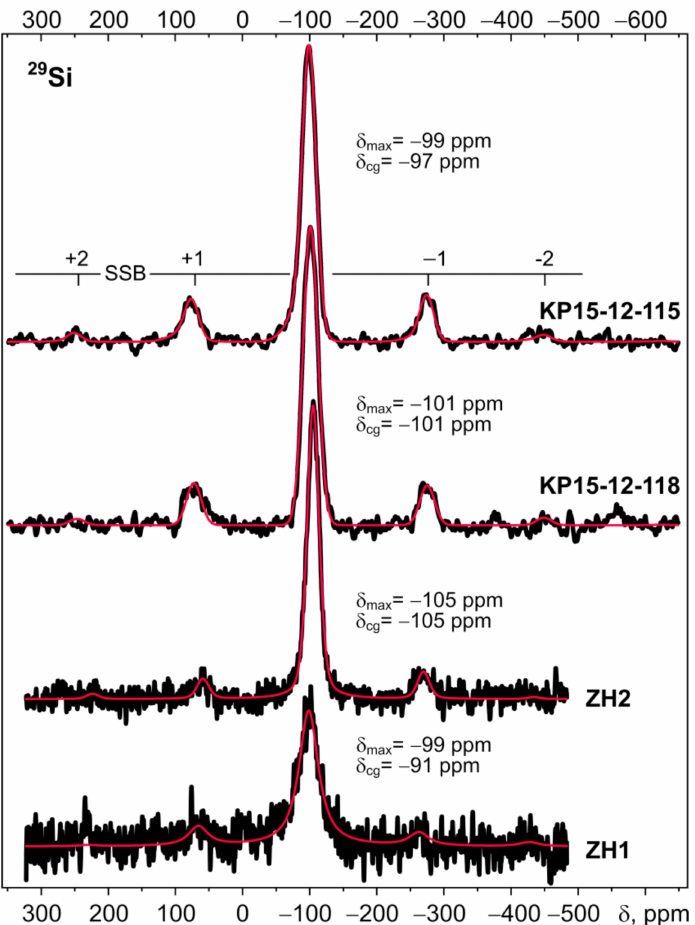
Figure 5. The overview 29 Si MAS NMR spectra of the studied glasses. Black line—experimental, and red lines—fitted